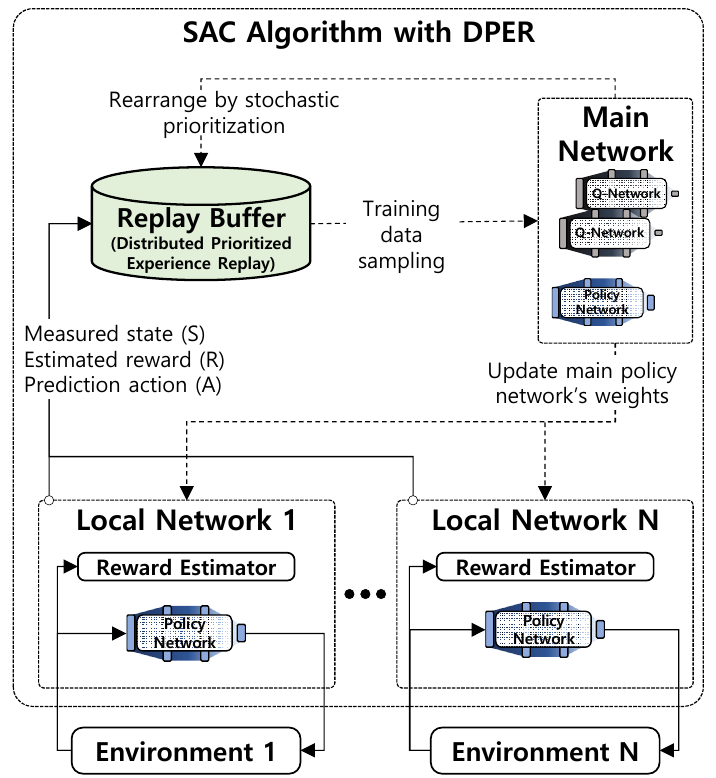
Figure 5. Training algorithm of SAC with DPER.